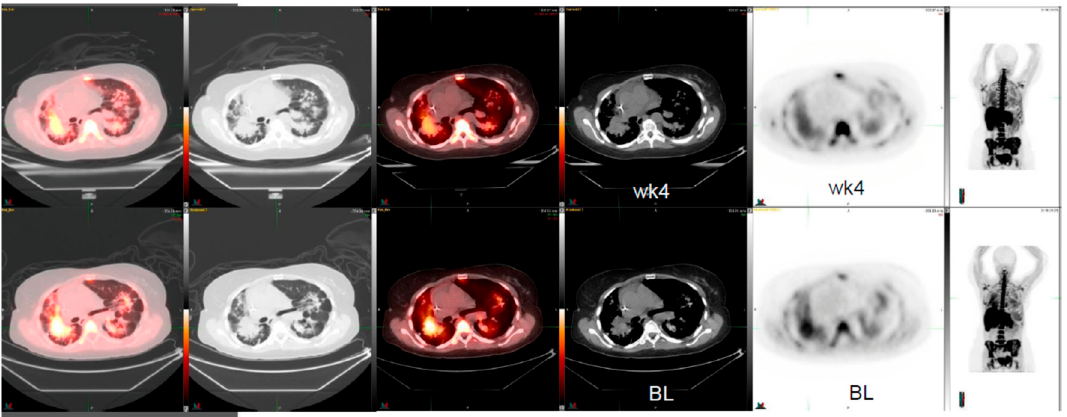
Figure 2. 18 F-FLT PET/CT scans shows weak signals of early response to MET inhibitor targeted therapy whereas the conventional CT scan images do not show any responses in a patient with lung adenocarcinoma (BL, baseline; wk4, at 4 weeks post